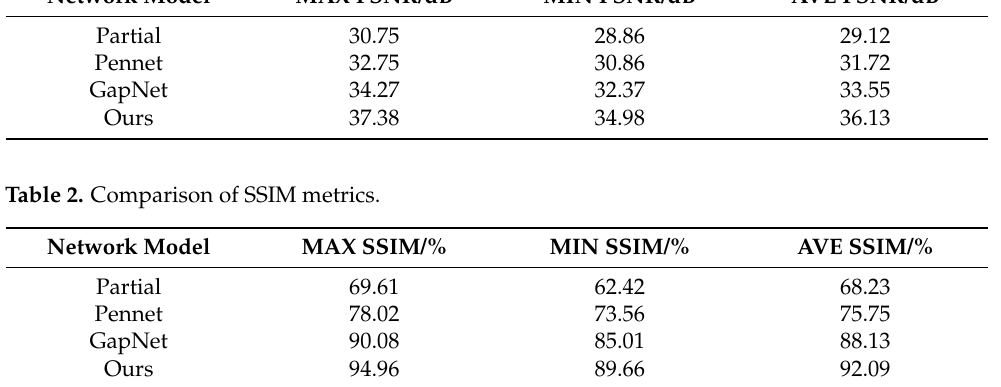
Table 1. PSNR comparison result.